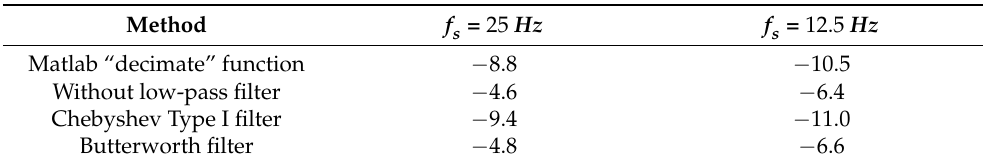
Table 2. Relative differences of accumulated damage at the critical angle of the cross section of the tower considering the different sampling methods and sampling frequencies [%].